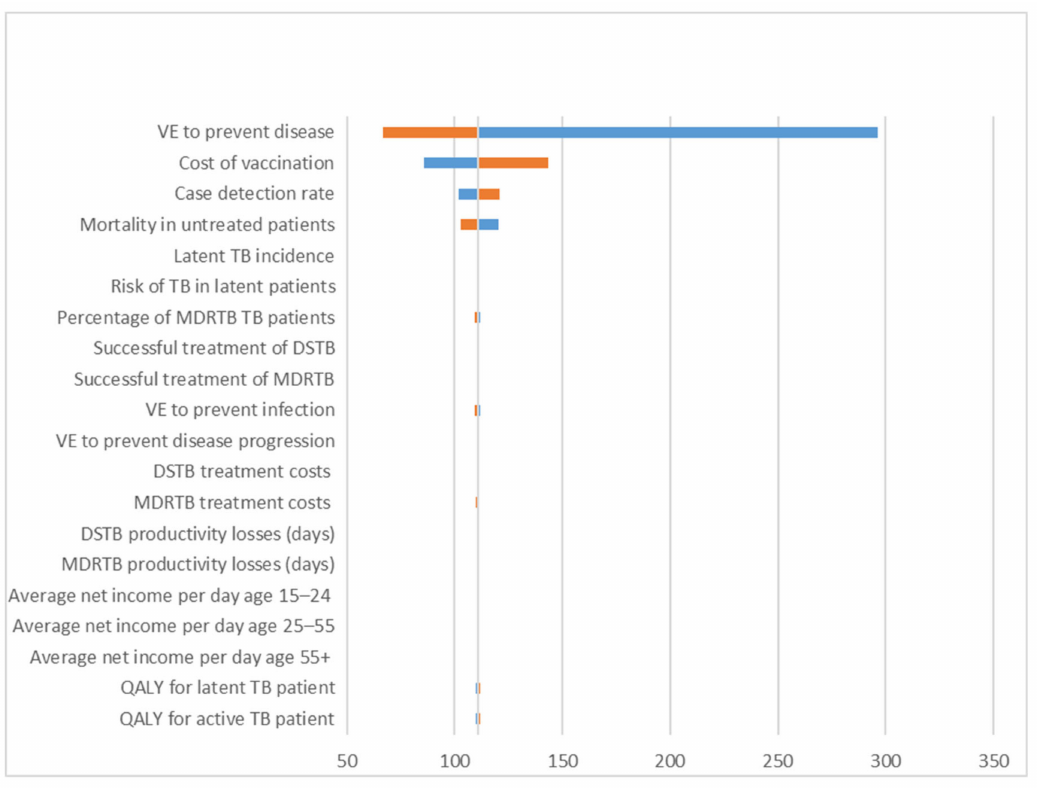
Figure 4. A tornado diagram of the univariate analysis. VE = vaccine e ff ectiveness, TB = tuberculosis, DSTB = drug-susceptible tuberculosis, MDRTB = multidrug-resistance tuberculosis, QALY = quality-adjusted life